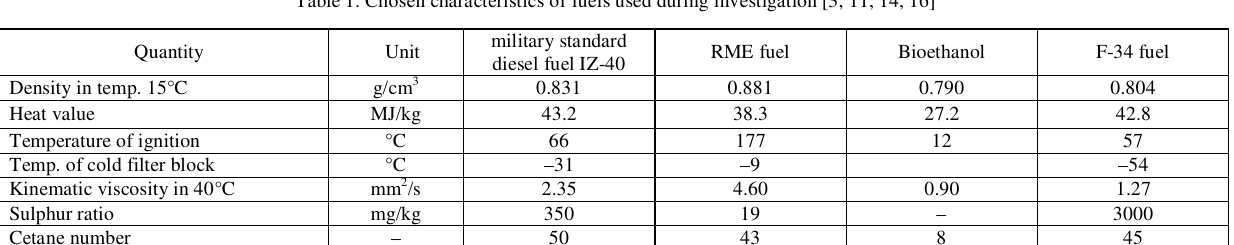
Table 1. Chosen characteristics of fuels used during investigation [3, 11, 14,